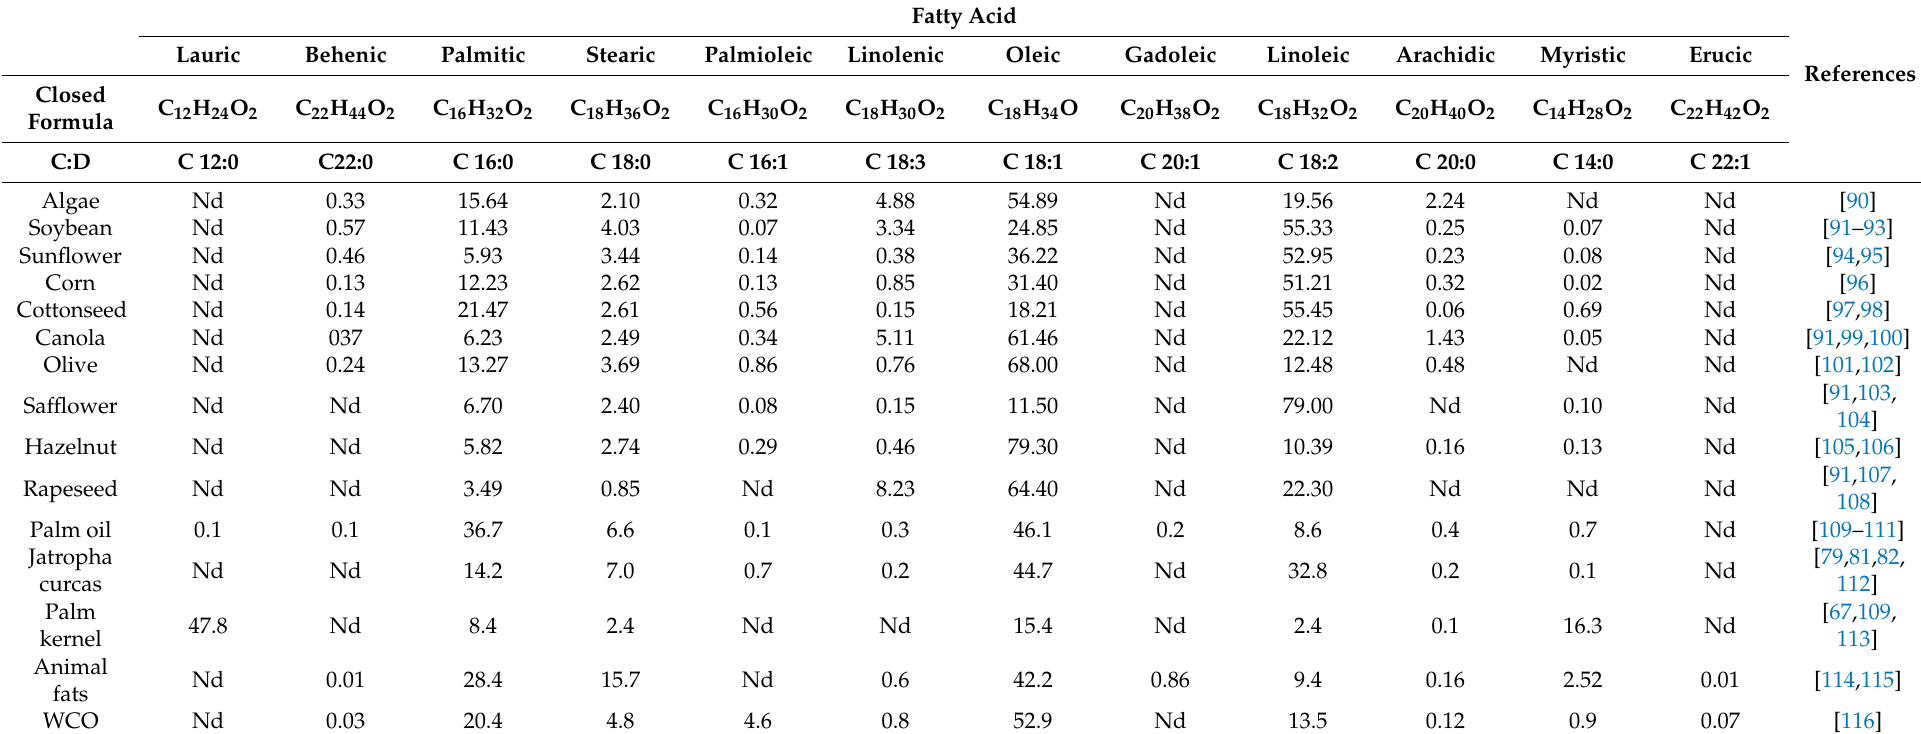
Table 2. Chemical composition of biodiesel